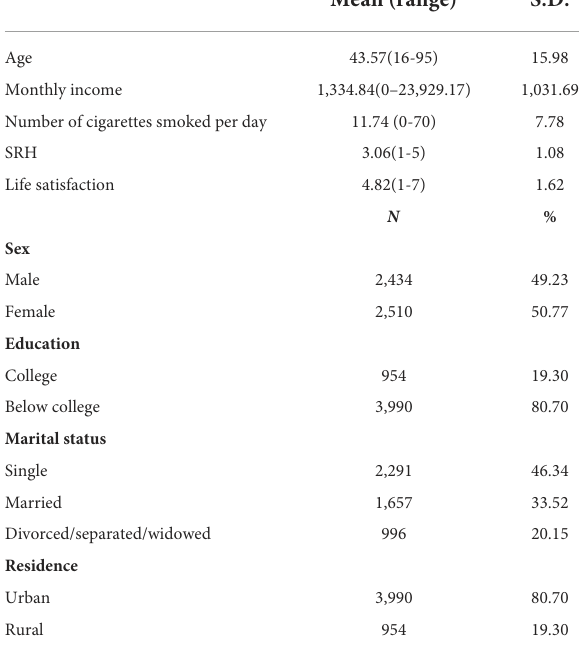
TABLE 1 Descriptive statistics with information about age, sex, monthly income, education, marital status, residence, the number of cigarettes smoked, SRH, and life satisfaction.